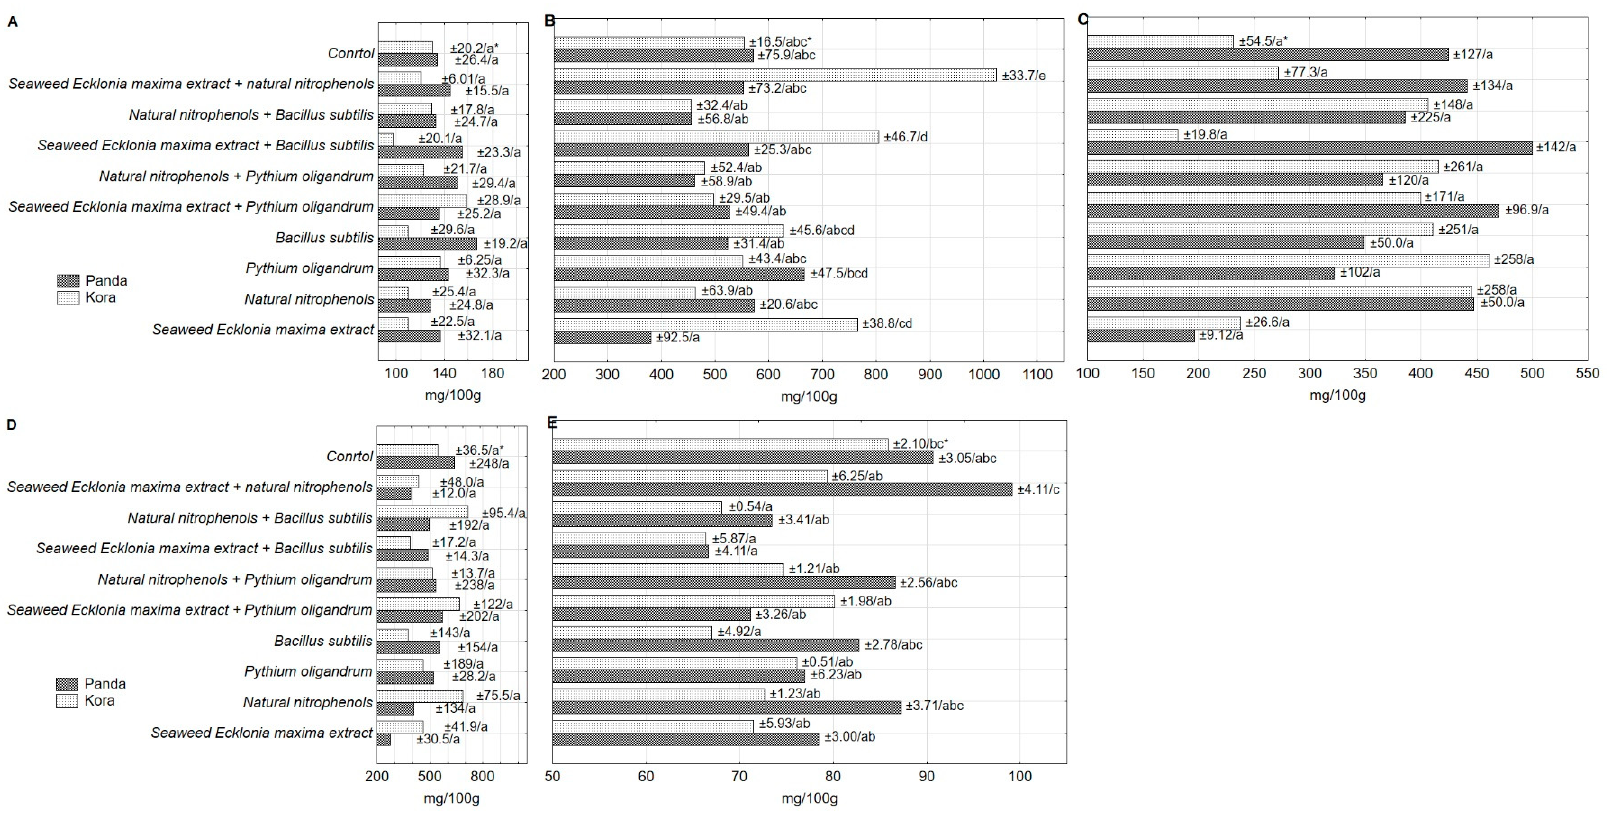
Figure 2. Effect of the treatment on organic acids (oxalic ( A ), malic ( B ), citric ( C ), succinic ( D ), fumaric ( E )) content in the buckwheat sprouts cvs. Panda and Kora. * standard error of mean/homogeneous groups.